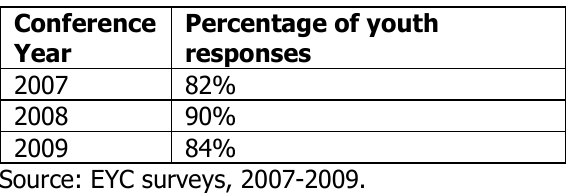
EYC attendees who would encourage a friend or family member to be environmentally conscious and/or commit to a green menu action